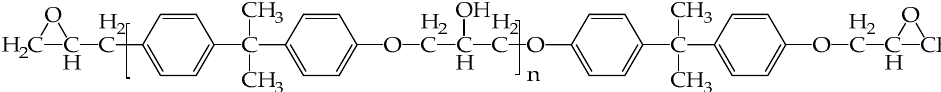
Polymers 2021 , 13 , x FOR PEER REVIEW Figure 2. The chemical information of epoxy. Figure 2. The chemical information of epoxy.